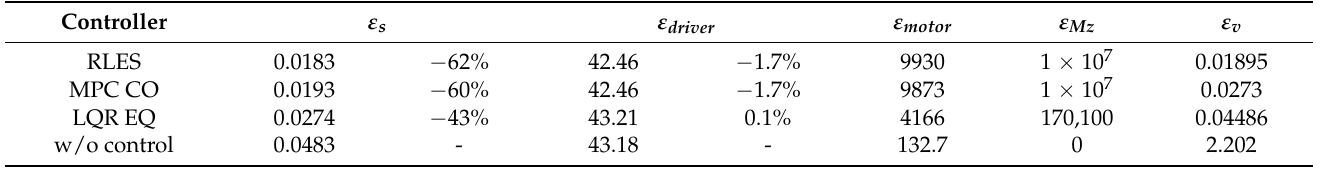
Table 4. Performance indicators in step steering maneuver.